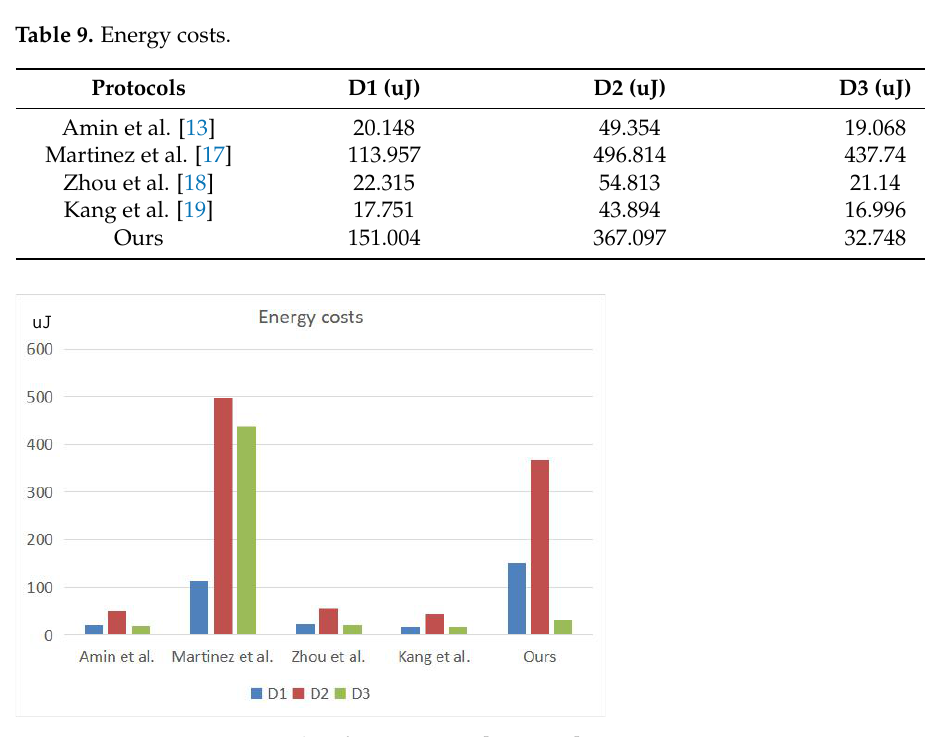
Figure 12. Comparative results of energy costs